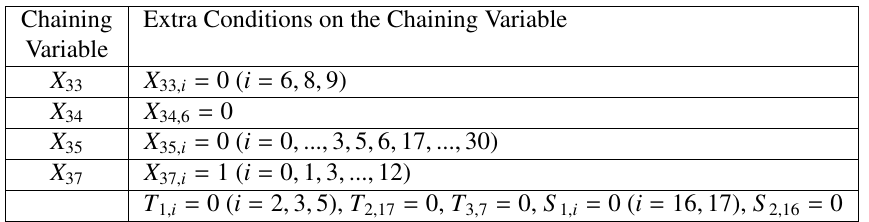
Table 10: The Extra Conditions of the Generalized Message Modification in the Left Branch Chaining Extra Conditions on the Chaining